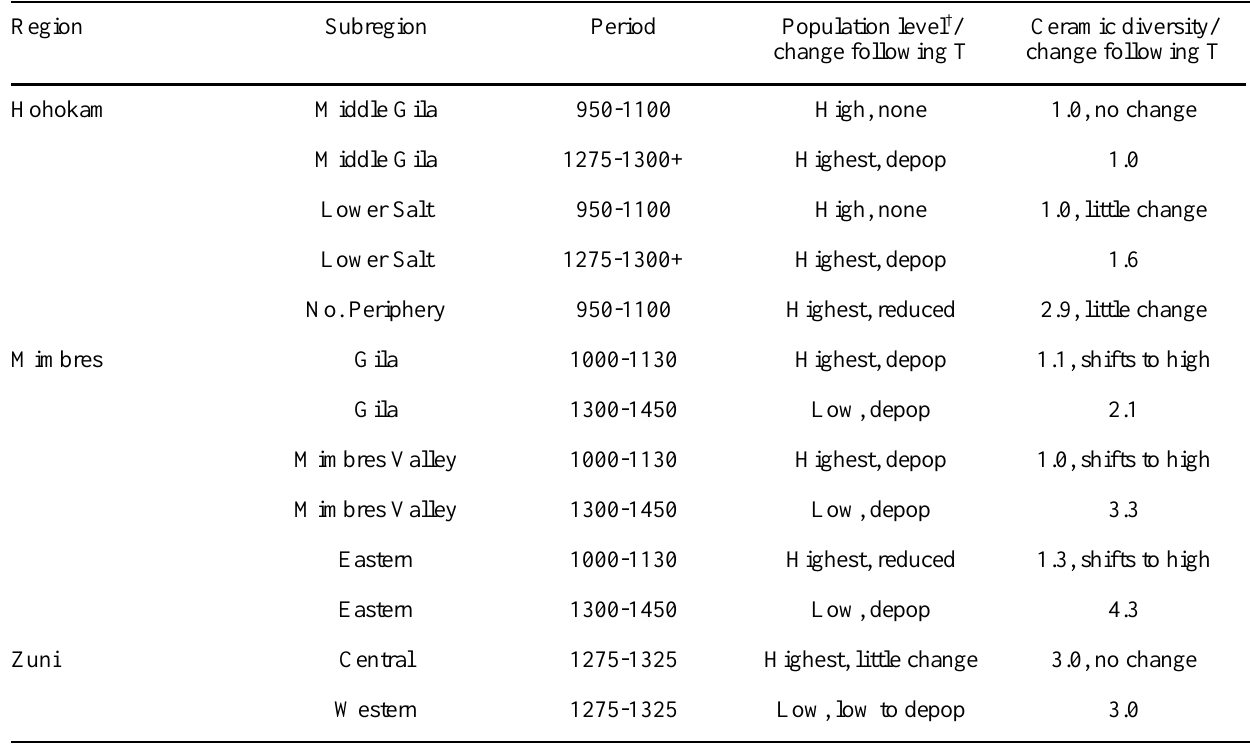
Table 2. Characteristics of time-space units immediately preceding dramatic transformations.